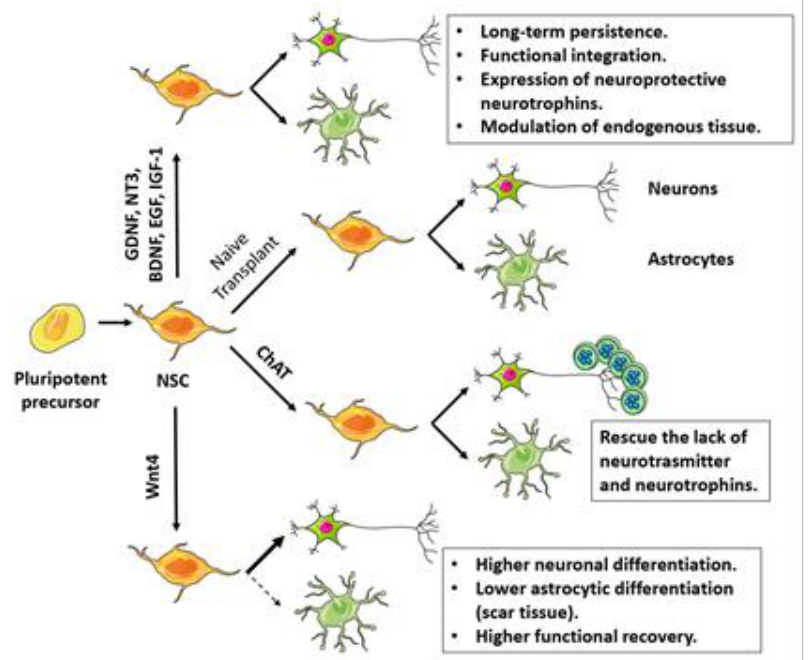
Figure 3. NSCs engineering strategies for transplantation in neurodegenerative disorders and their purposes. GDNF, BDNF, EGF, IGF-1 and NT3 overexpression improved long-term survival and modulated functional recovery after transplantation. Wnt-4 overexpression shifted differentiation toward neural phenotype reducing scar tissue formation and improving functional recovery. NSCs overexpressing neurotrophins (i.e., GDNF, BDNF, NT-3, and NGF) display improved